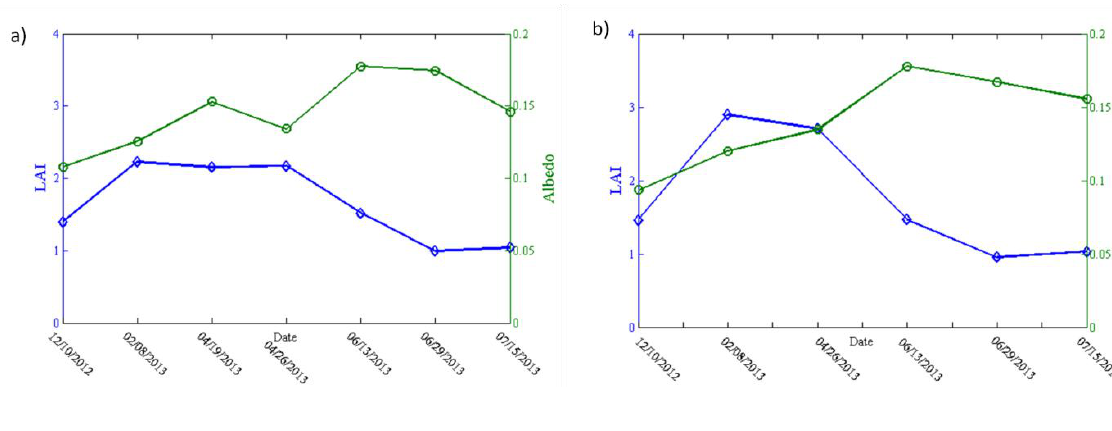
Figure 9. Temporal profile of LAI (Blue) and Albedo (green) in the Sidi Bennour ( a ) and Zemamra ( b ) districts.; both LAI and albedo are mean values over each